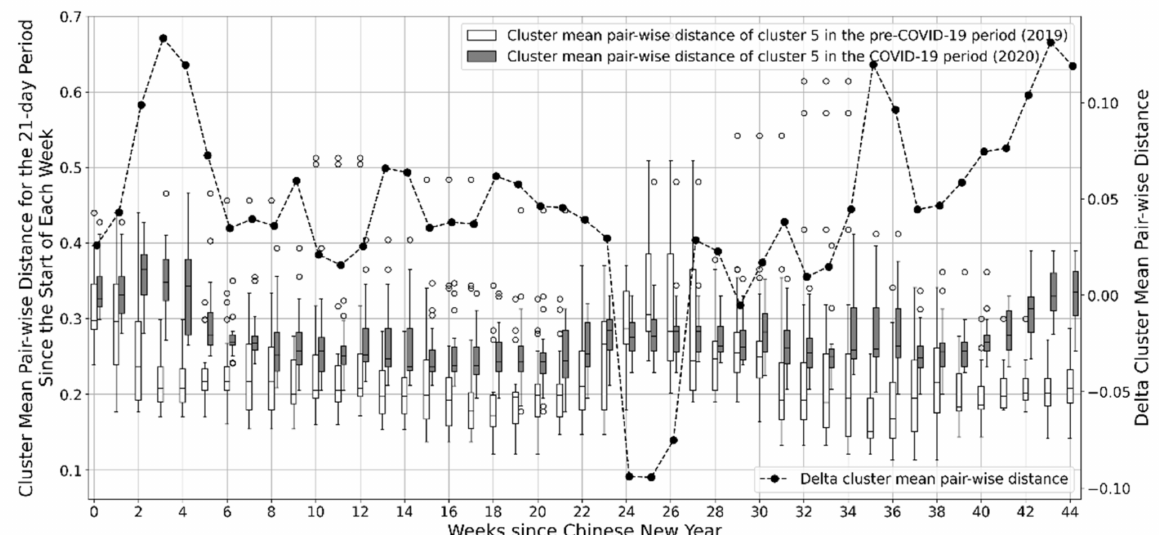
Figure 11. Boxplot comparison of the cluster mean pairwise distance of cluster 5 between the COVID-19 period and the pre-COVID-19 period (each green or blue boxplot represents the cluster mean pairwise distance for the 21-day period from the indicated week on the x -axis; delta cluster mean pairwise distance is the difference between the cluster mean pairwise distance of the COVID-19 period and the pre-COVID-19 period).